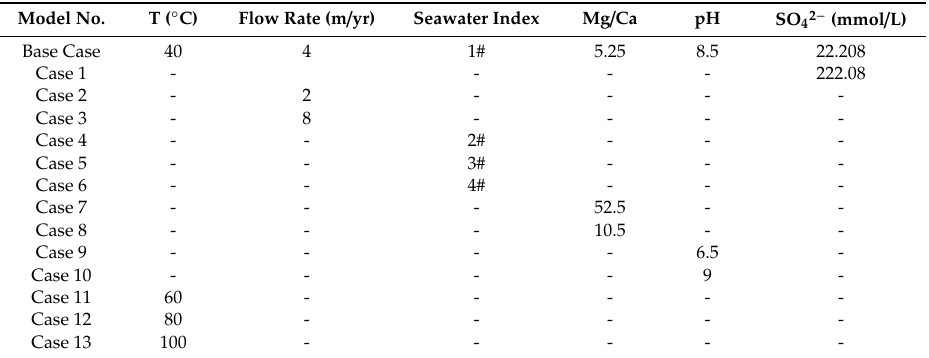
Table 1. Parameters setting for one-dimensional flow models.